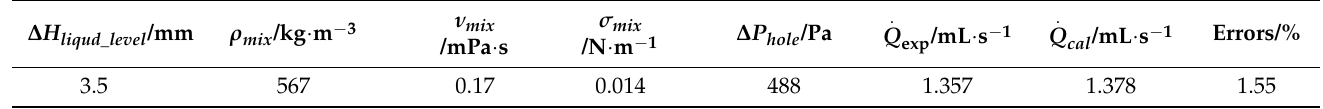
Table 2. Experiment and simulation results of liquid volume-flow rate through the liquid-return